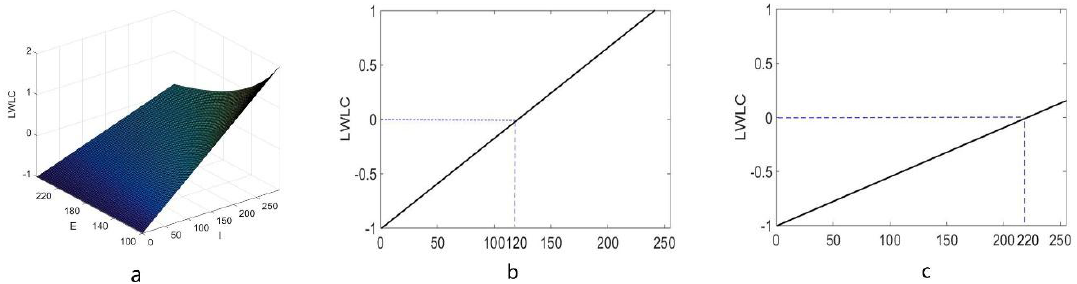
Figure 5. The surface of LWLC (Local Weber-like Contrast) measure. ( a ) The surface of LWLC. ( b ) The curve with E = 100. ( c ) The curve with E = 120.